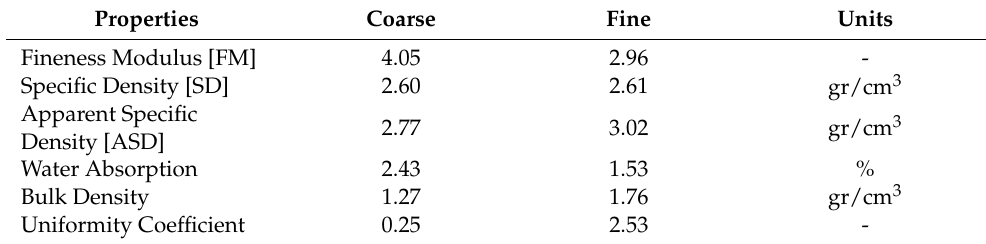
Table 2. Coarse and fine aggregate characterization summary.